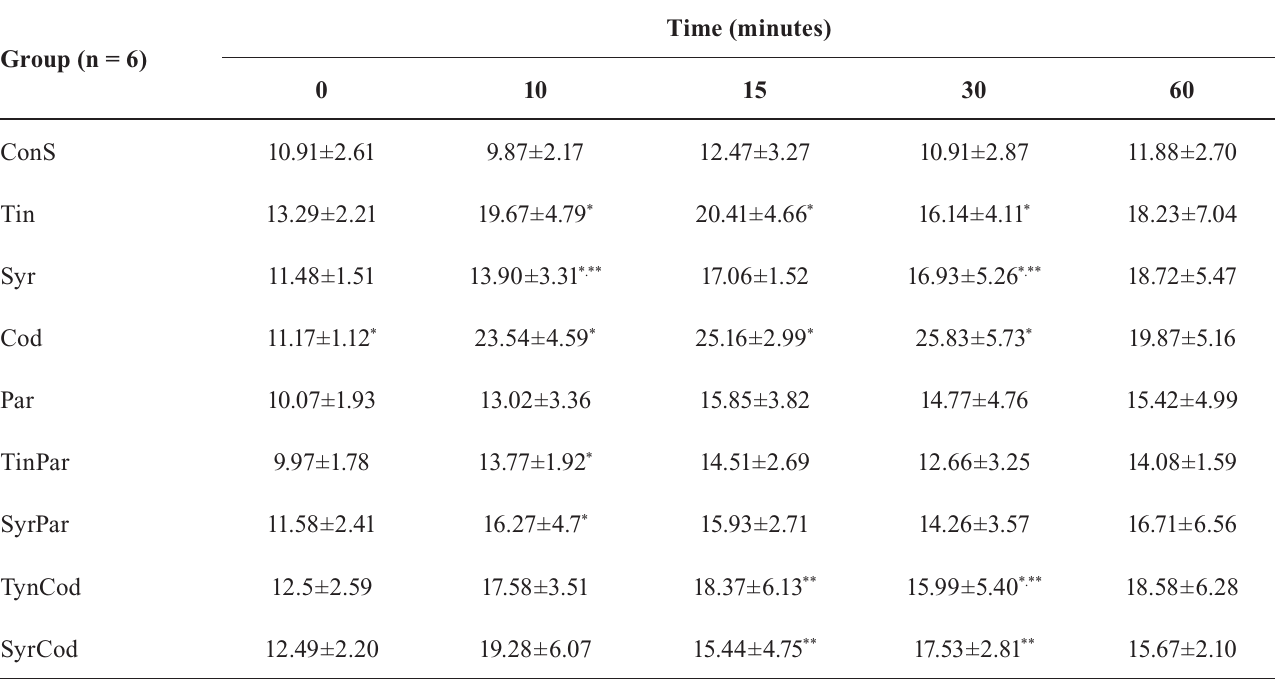
TABLE II - Effects of the 7 day pretreatment with Thymus Vulgaris tincture and syrup on the results of the hot plate test in mice. Data are presented as mean ± S.E.M